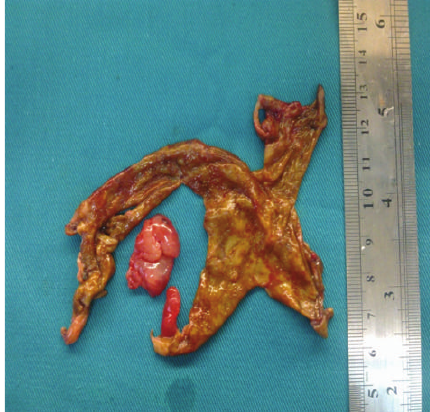
Figure 2: Endometrioma capsule and decidual structure.